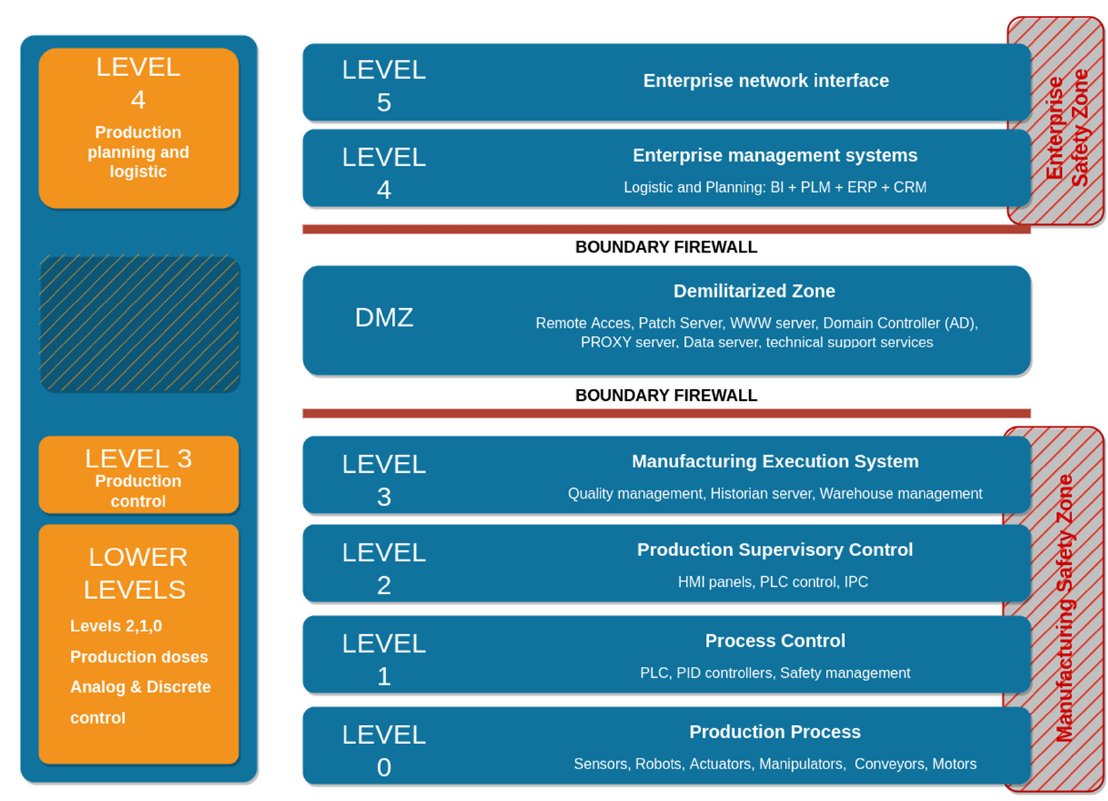
Figure 13. The implementation of the PERA model in production systems.